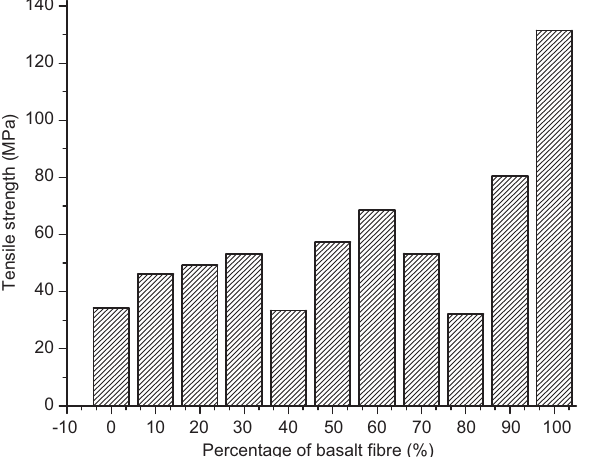
Figure 1 Effect of the fiber percentage on tensile strength.